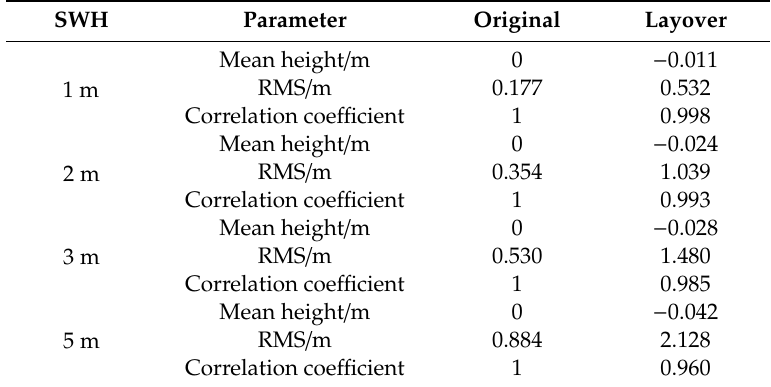
Table 6. The influence of layover under di ff erent SWH (the propagation direction is 0 ◦ , the wavelength is 200 m).